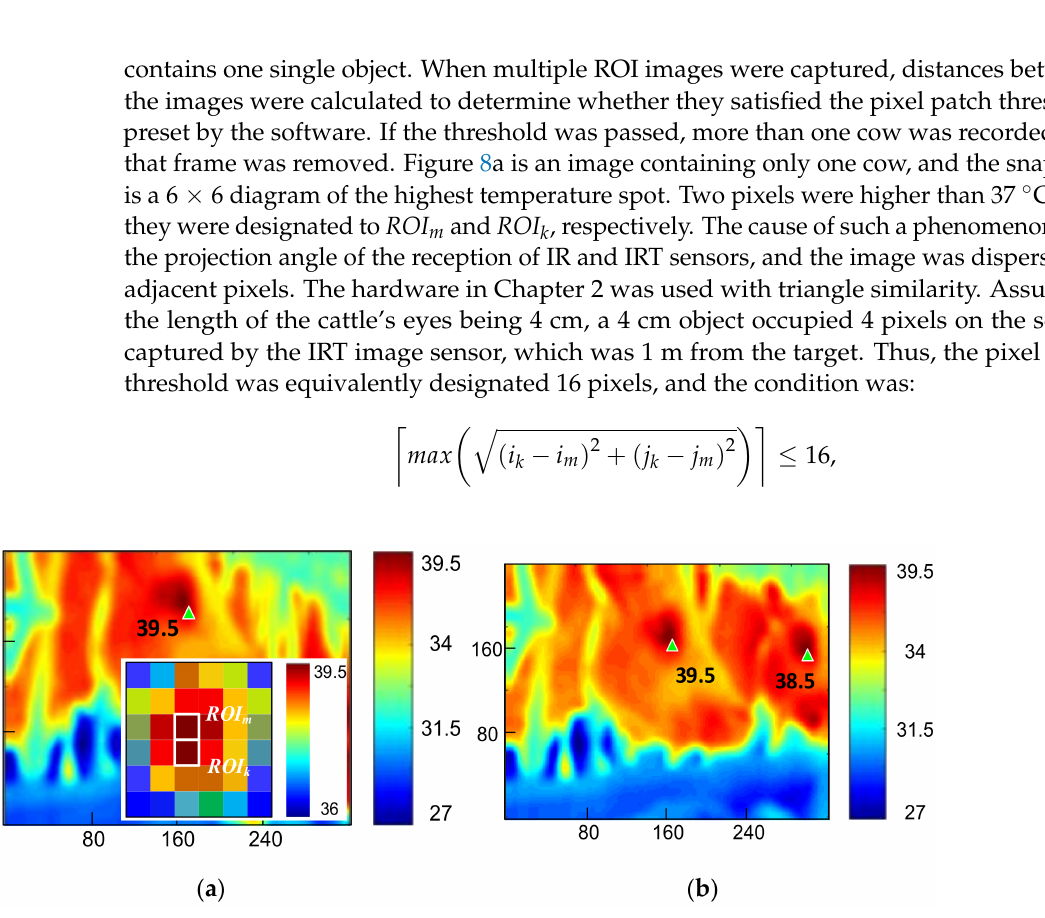
Figure 8. Region of interest in each frame. ( a ) A frame with only one cow. ( b ) A frame with two